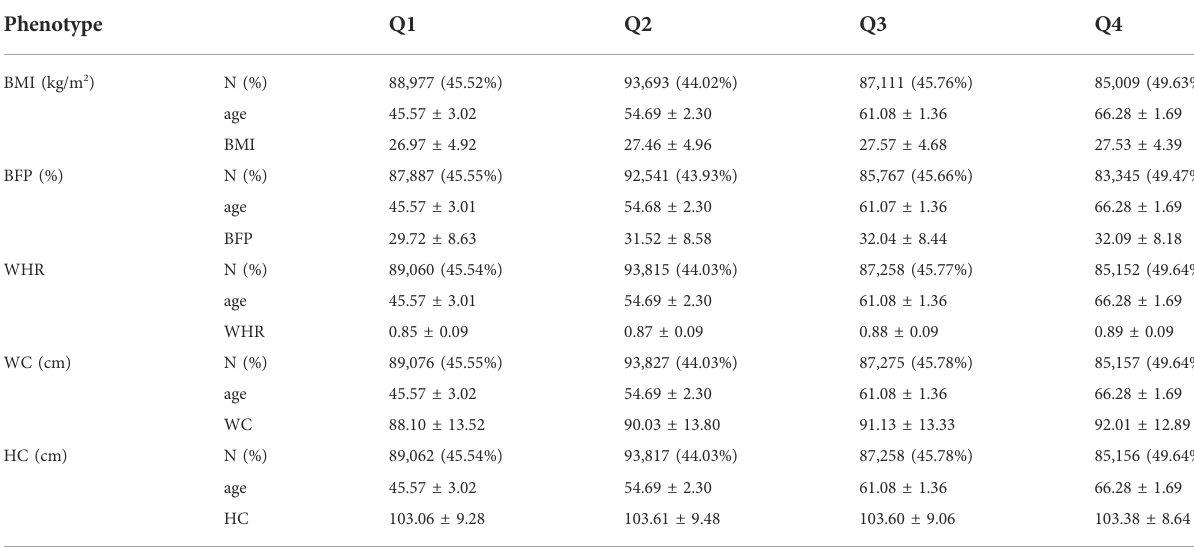
TABLE 1 Basic characteristics of the United Kingom Biobank